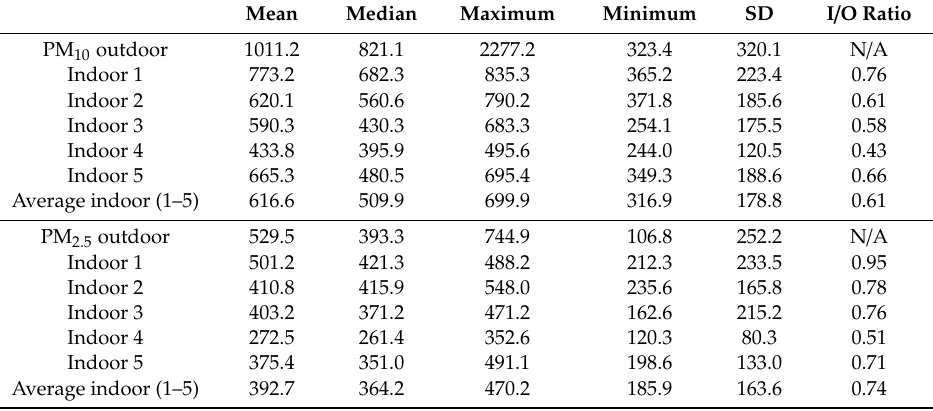
Table 1. Statistical description of particulate matter (PM) concentrations (µg m − 3 ), and the ratio of indoor-to-outdoor (I/O) during the dust event based on the real-time PM record with time interval of 5 minutes ( n = 30). (SD—standard deviation).